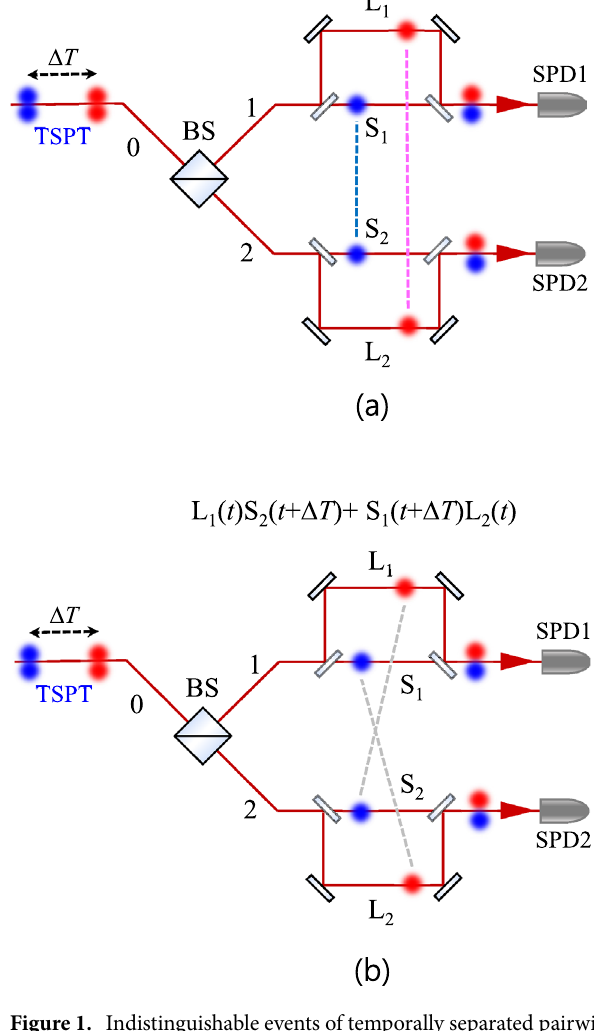
Figure 1. Indistinguishable events of temporally separated pairwise two-photon states in Franson-type interferometry. Coincidence events of the two detectors at τ = 0 in cases of ( a ) short-short (S 1 S 2 ) and long-long (L 1 L 2 ) paths and ( b ) long-short (L 1 S 2 ) and short-long (S 1 L 2 )